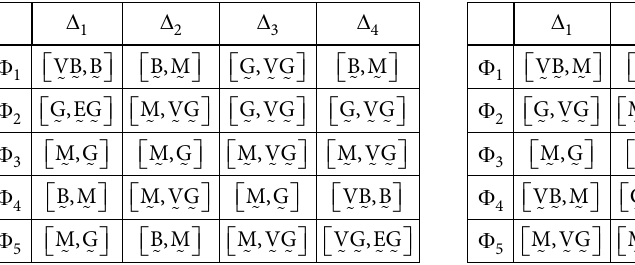
Table 8. The standardized ULT matrix from Table 9. The standardized ULT matrix from